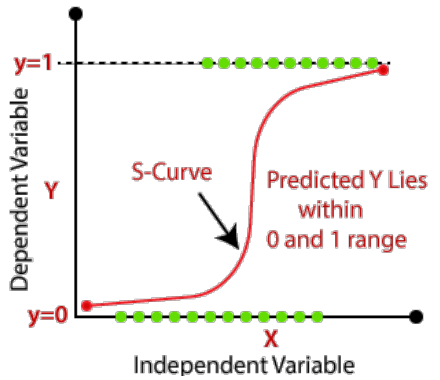
Figure 8. Logistic regression representation [38].